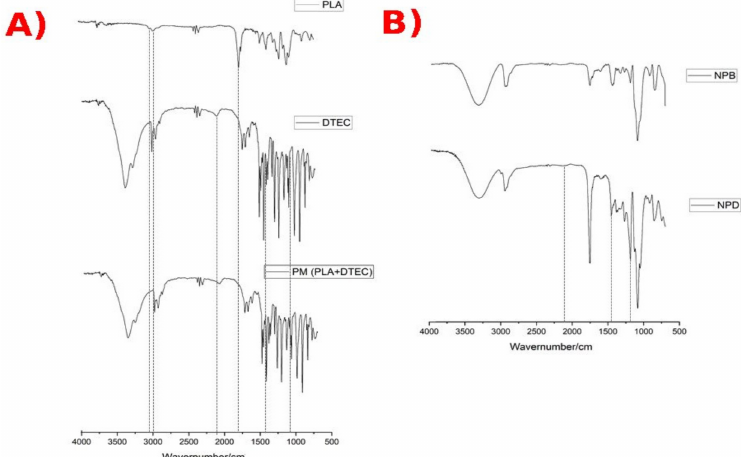
Figure 2. FTIR-ATR analysis. ( A ) Spectrum in region IV of the individual pure compounds and the compound physical mixture. ( B ) Spectrum in region IV of the drug-free (NPB) and DETC-loaded nanoparticles